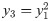
Visualization of three-dimensional linear Koopman system from Eq (25) along with projection of dynamics onto the x1-x2 plane.The attracting slow manifold is shown in red, the constraint y3=y12 is shown in blue, and the slow unstable subspace of Eq (25) is shown in green. Black trajectories of the linear Koopman system in y project onto trajectories of the full nonlinear system in x in the y1-y2 plane. Here, μ = −0.05 and λ = 1. Figure is reproduced with Code 1 in S1 Appendix.